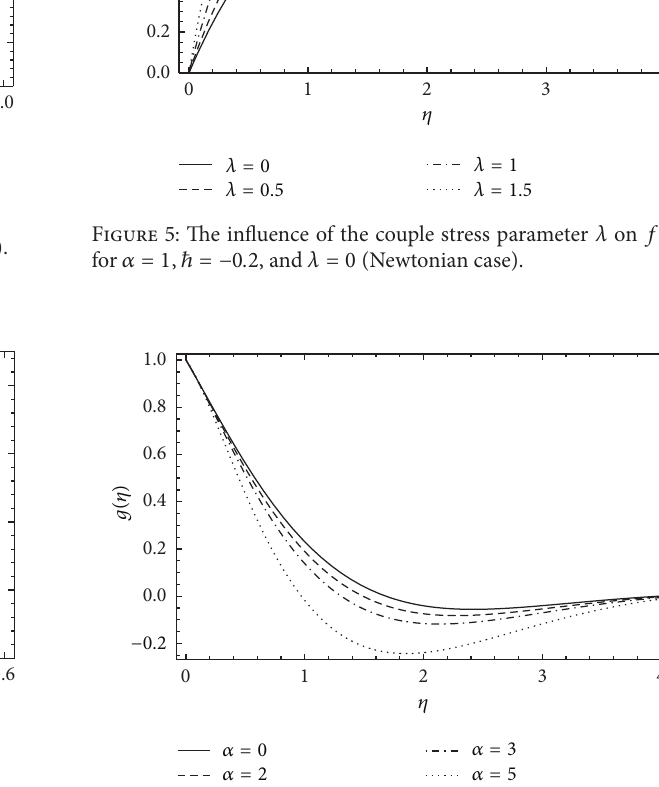
Figure 3: The ℏ curves for 𝑓 󸀠󸀠󸀠 (0) , 𝑔 󸀠󸀠 (0) , 𝑘 󸀠󸀠 (0) , and ℎ 󸀠󸀠 (0) .